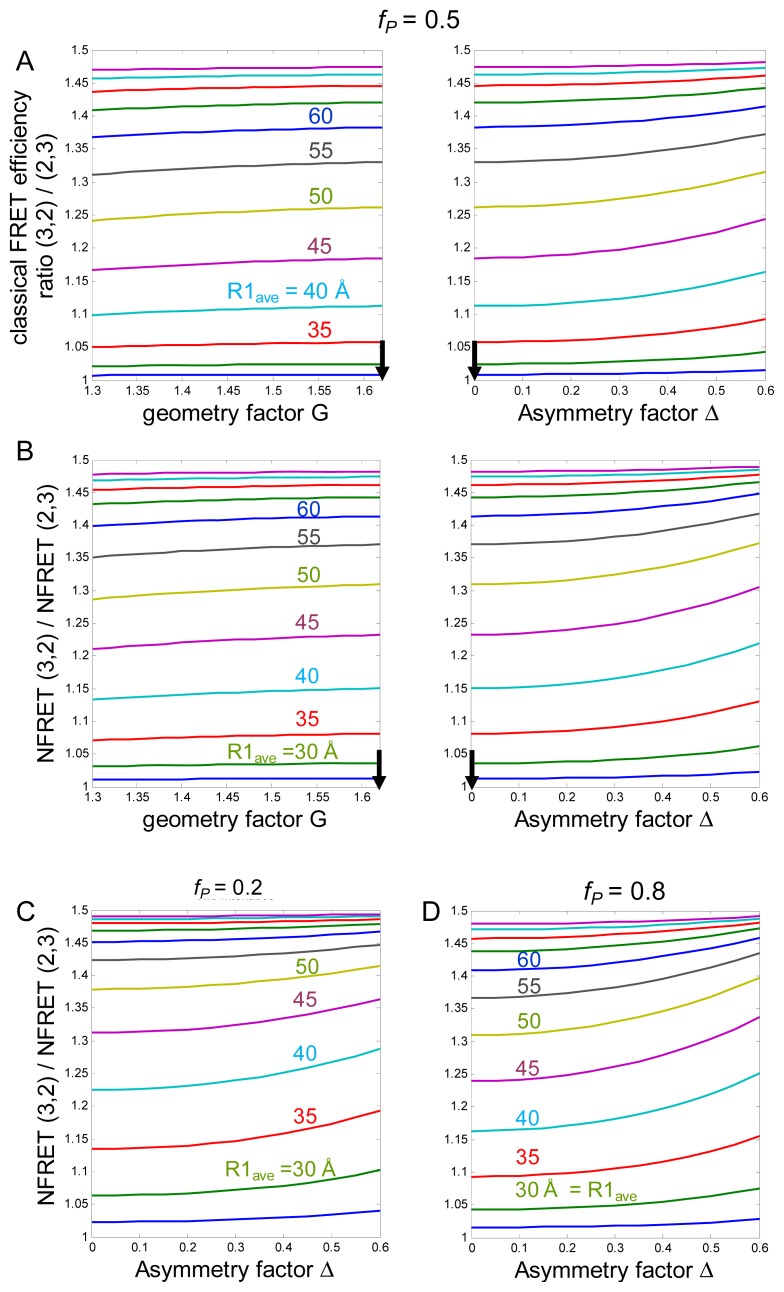
Simulations. (A) The y-axis is the simulated Ē3,2 / Ē2,3, the ratio of classical FRET efficiency for the two stoichiometries. The vertical arrows give parameters associated with the regular pentagonal receptor. The theoretical curves are computed for various values of the average distance between fluorophores on adjacent subunits R1,ave. X-axes are (left) the geometry factor G, and (right) the asymmetry factor Δ. The assumed fP = 0.5; (B) Same parameters as in (A); the plotted values are NFRET3,2/NFRET2,3, the ratio of NFRET efficiency for the two stoichiometries; (C) (D) Values of NFRET3,2/NFRET2,3
vs. asymmetry factor Δ for assumed fP = 0.2 (C) or 0.8 (D).